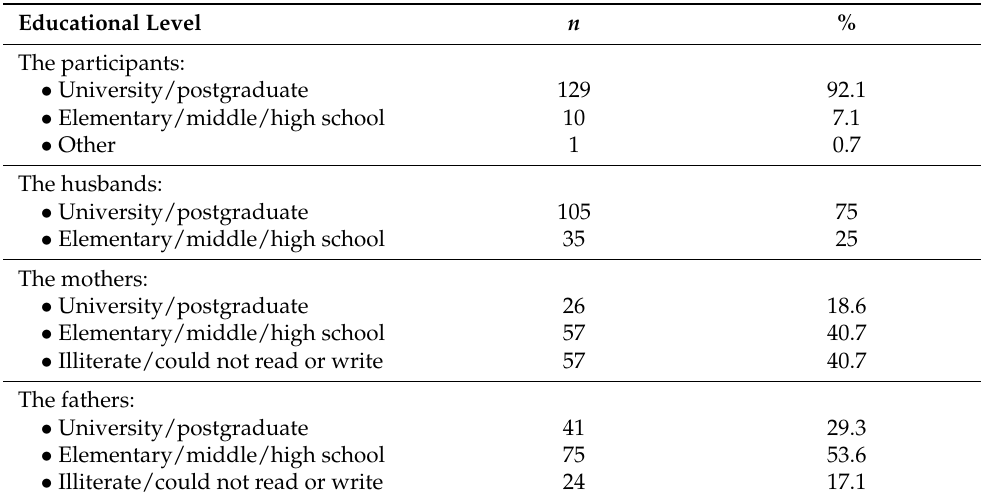
Table 2. Educational levels of the participants and their husbands, mothers, and